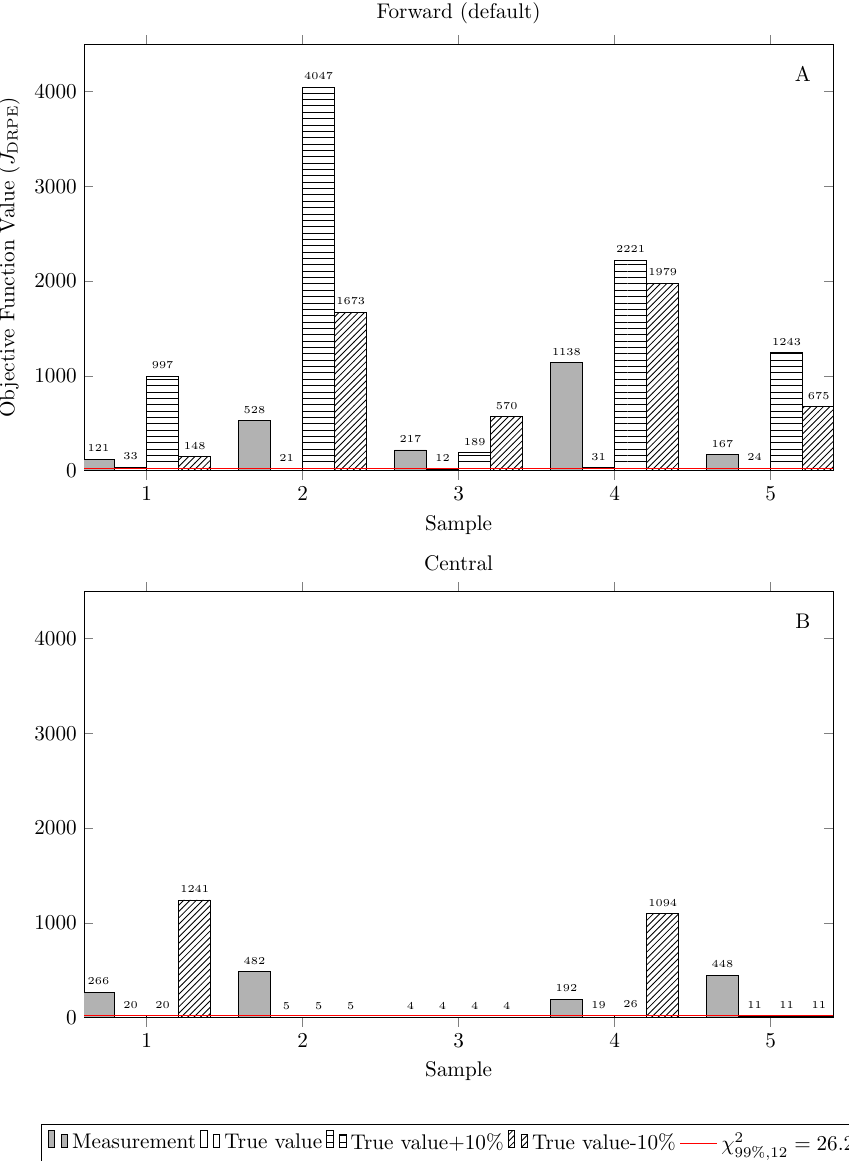
Figure 3. Final objective function values after solving the DR problem as a function of the initial guess. ( A ) Forward finite difference; ( B ) Central finite